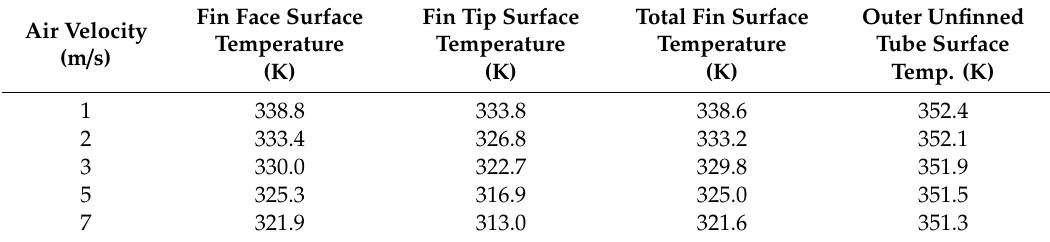
Table 4. Average temperature of fin surfaces.